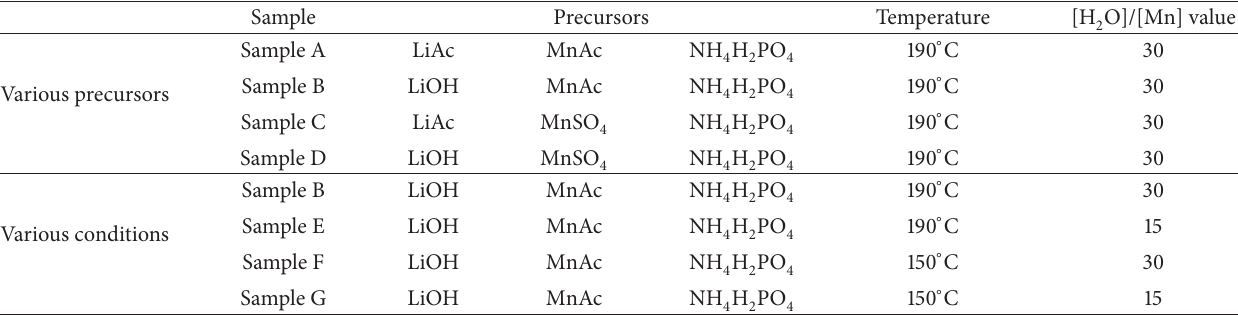
Table 1: The list of precursors and conditions for sample preparation.